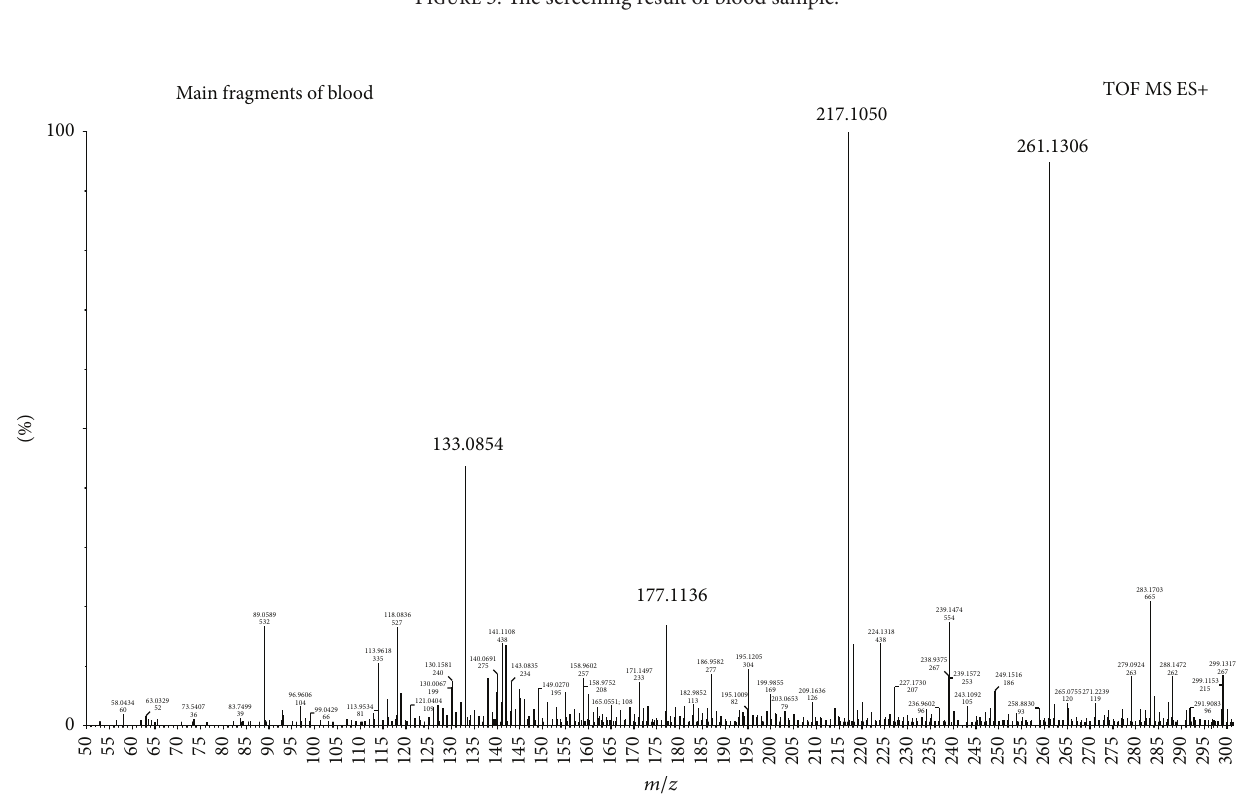
Figure 5: The screening result of blood sample.